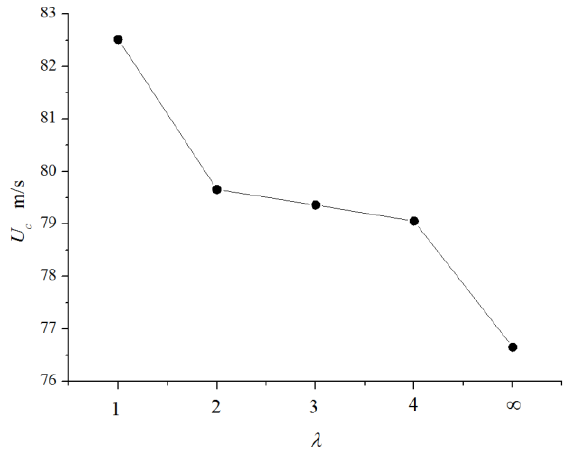
Figure 12. Flutter wind speed versus relative suction interval.